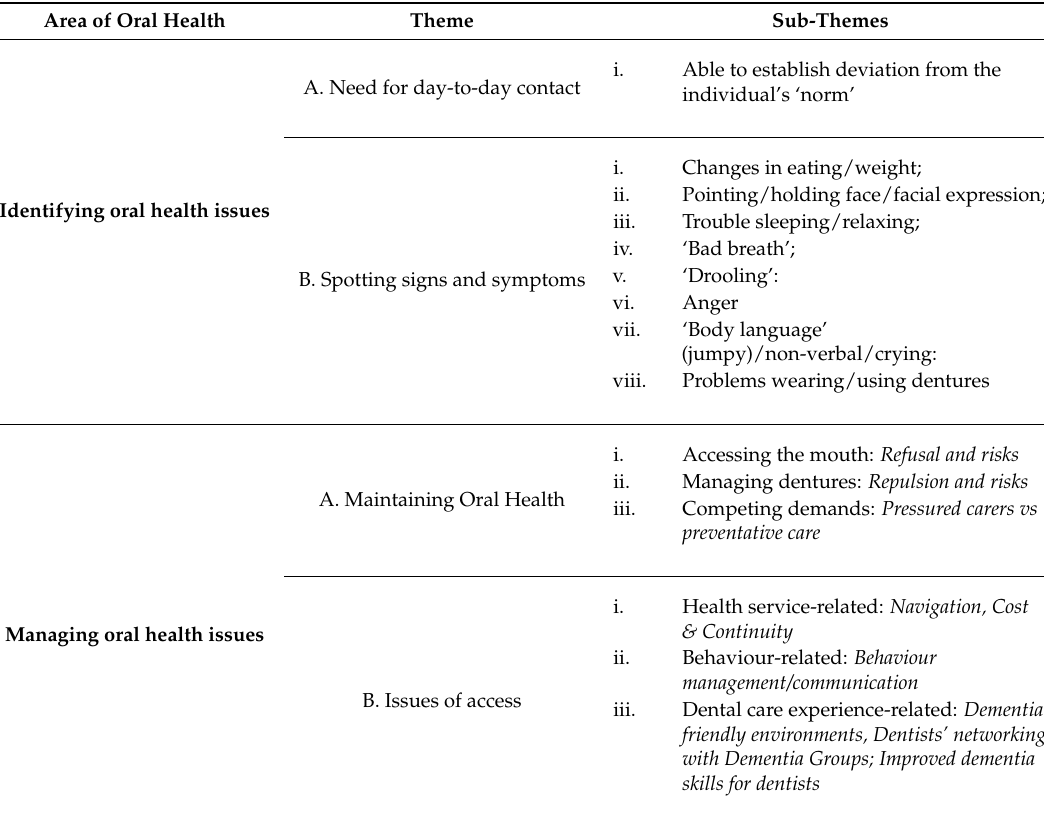
Table 1. Areas of results with themes and